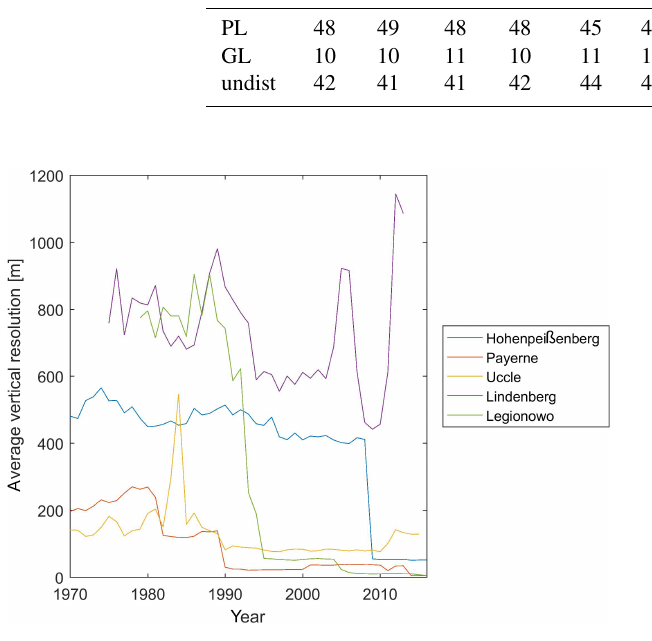
Figure 6. The annual variation of the lamina number per ozone pro- file for PL (group of lines with the strong variation) and for GL (group of lines with the weak variation) at the European ozonosonde